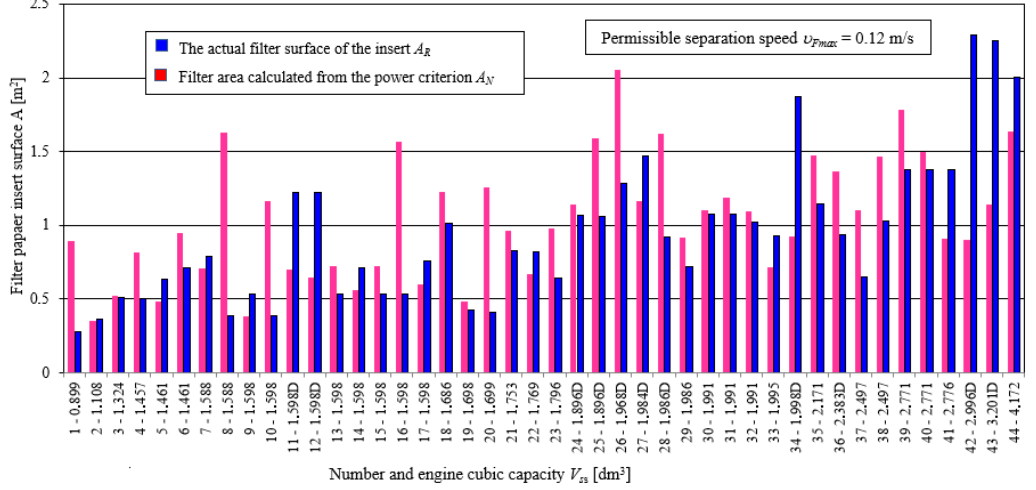
Fig. 7. Comparison of the paper surface used in passenger car engine filter inserts: the actual A rz and the calculated A N for the separation speed 